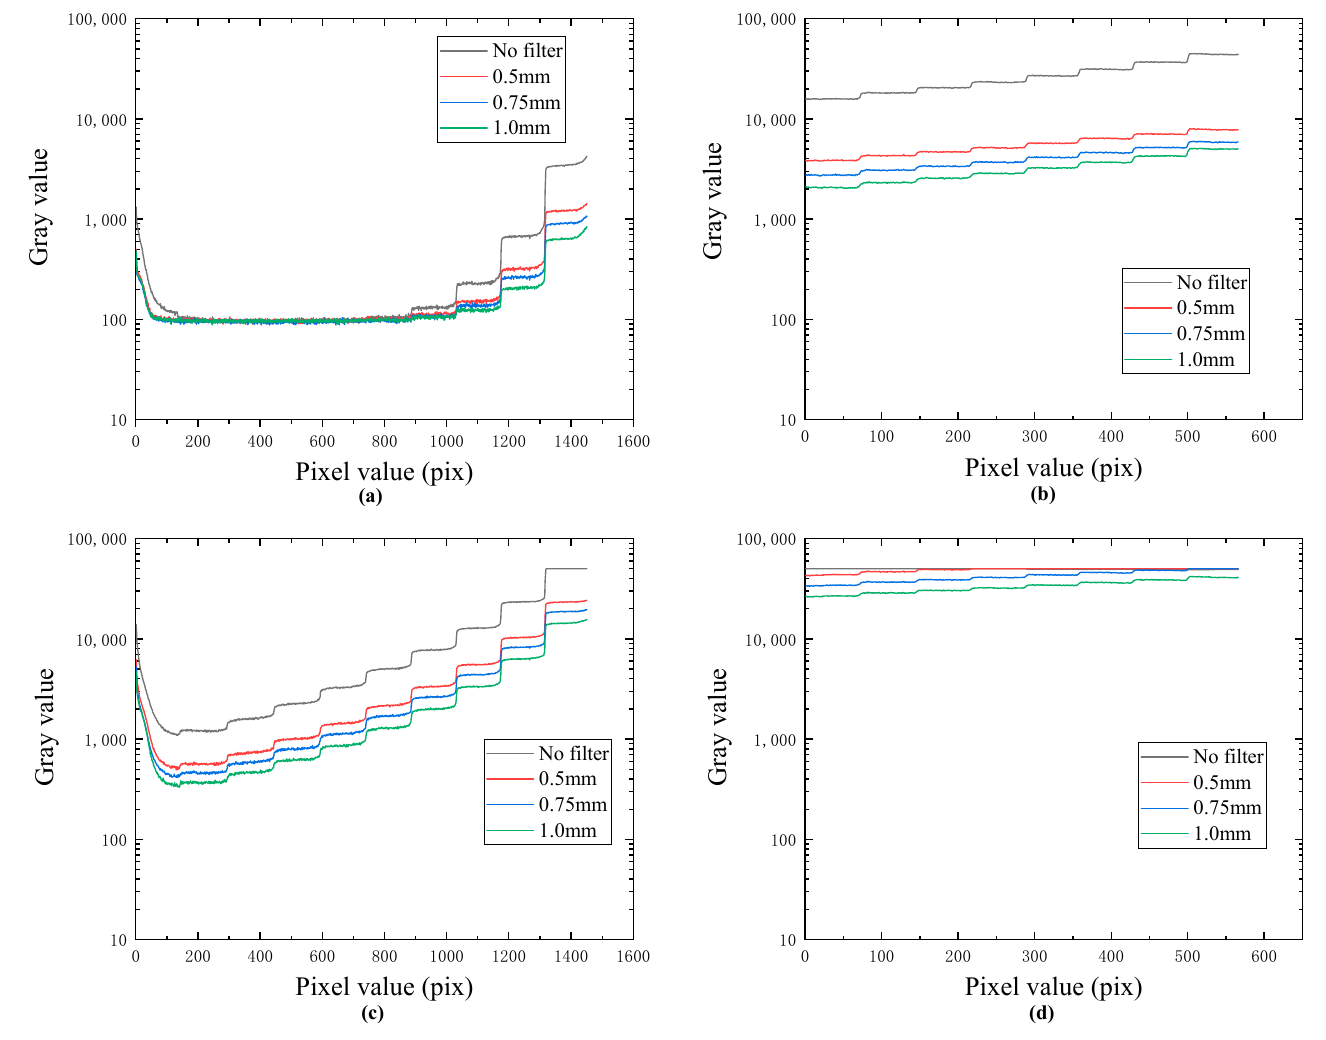
Figure 4. ( a ) Gray scale curve of iron image under 90 kV exposure; ( b ) gray scale curve of aluminum image under 90 kV exposure; ( c ) gray distribution curve of iron image under 180 kV exposure; and ( d ) gray distribution curve of aluminum image under 180 kV exposure.